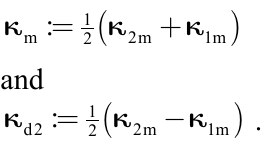
is the mid-corneal m